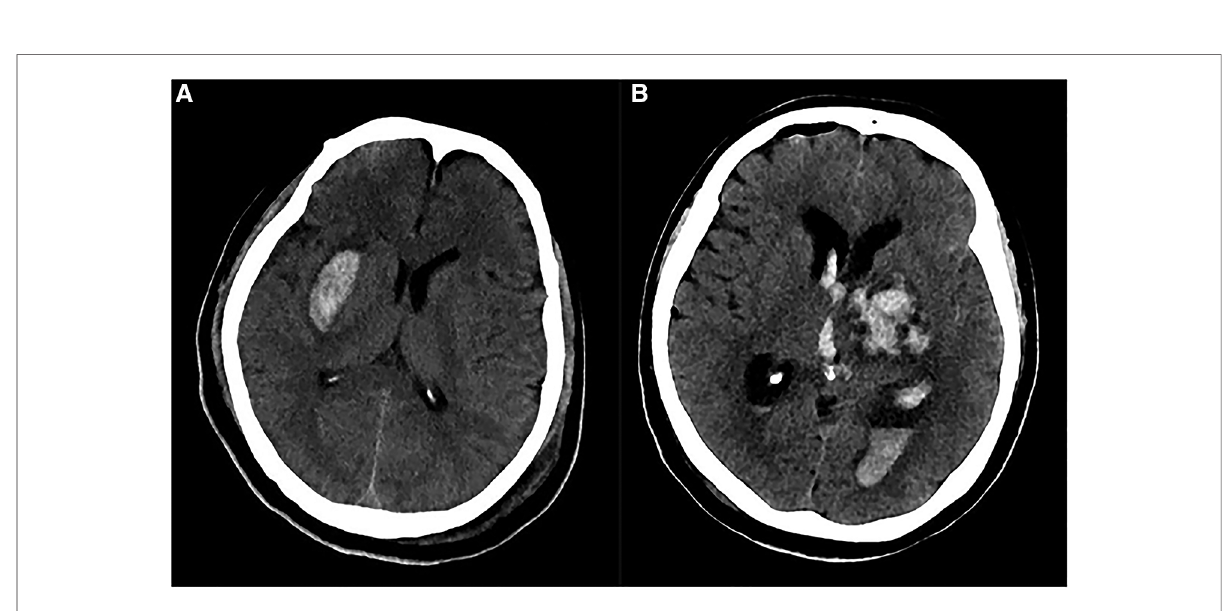
FIGURE 5 Postoperative imaging of patients with basal ganglia hemorrhage. ( A ) Postoperative CT in a patient with left TN showed a right external capsule hemorrhage. ( B ) Postoperative CT in a patient with right TN showed a left basal ganglia hemorrhage which ruptured to ventricles.